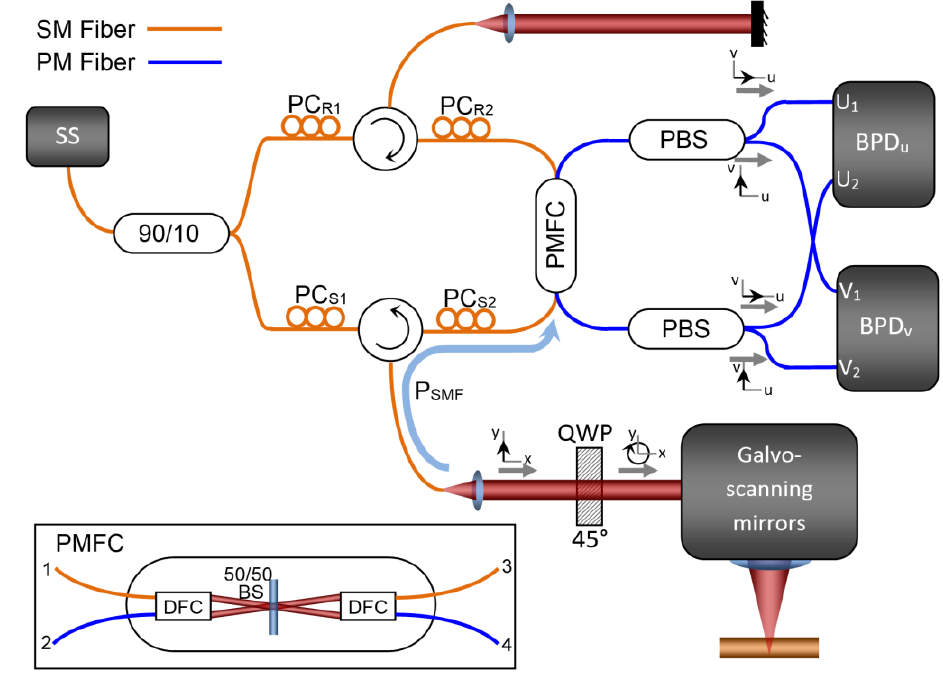
Figure 1. Polarization sensitive optical coherence tomography (PSOCT) system; SS: swept source, PC: polarization controller, QWP: quarter-wave plate, PBS: polarizing beam splitter, PMFC: polarization maintaining fiber coupler, BPD: balanced photo-detector. Inset: Internal schematic of the micro-optic 50/50 PMFC; DFC: dual fiber collimator, 50/50 BS: non-polarizing 50/50